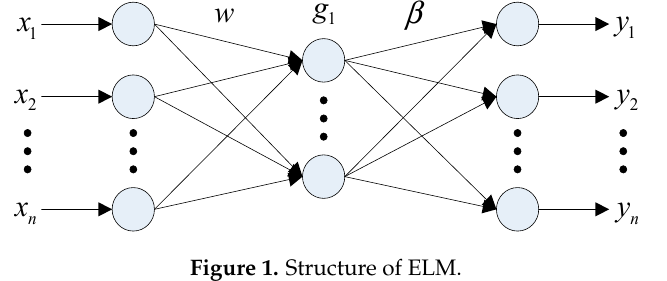
Figure 1. Structure of ELM.